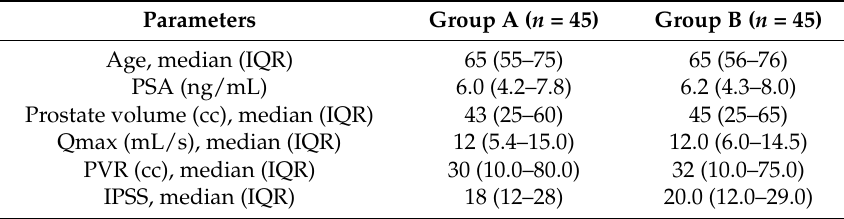
Table 1. Baseline characteristics of patients.